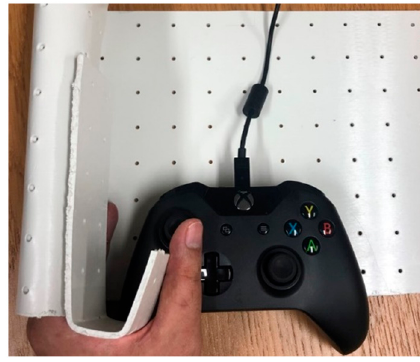
Figure 12. Use of a restraining device to reproduce the insufficient input scenario.